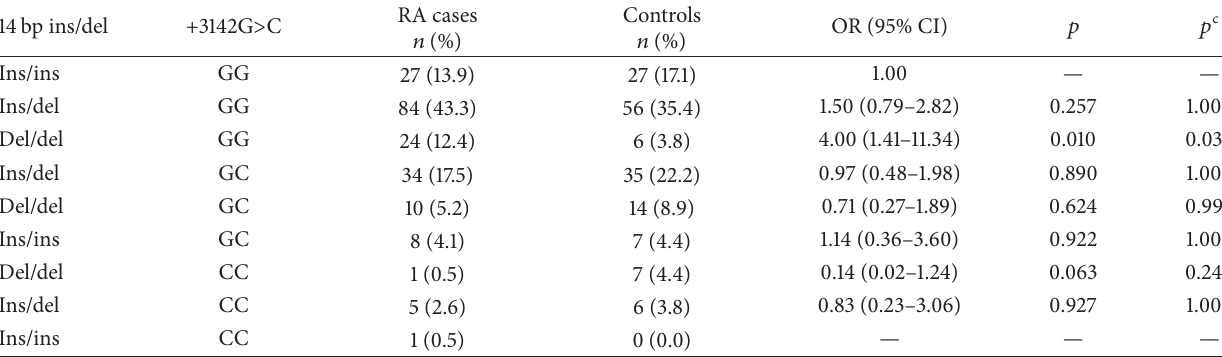
Table 2: Interaction of 14bp ins/del and +3142G > C polymorphism of HLA-G gene on rheumatoid arthritis (RA) risk.